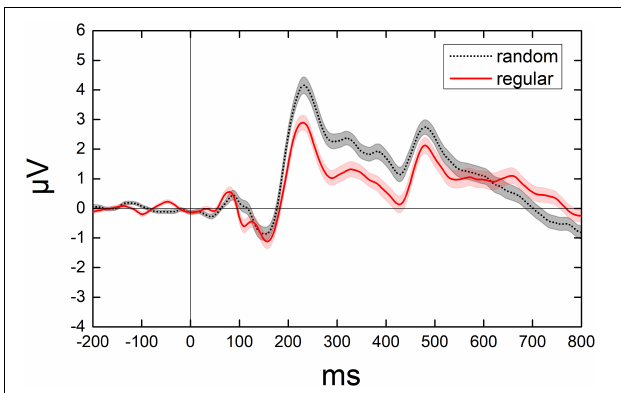
FIGURE 4 | Illumination for the dynamic change of average ERPs from 14 electrodes. The average value of average ERPs of participants from 200 ms before to 800 ms after each test. Black curves denote the ERPs when randomly distributed dots were presented. Red curves denote the ERPs when the regularly distributed dots were presented. Shadowed area denotes 1 SE of the